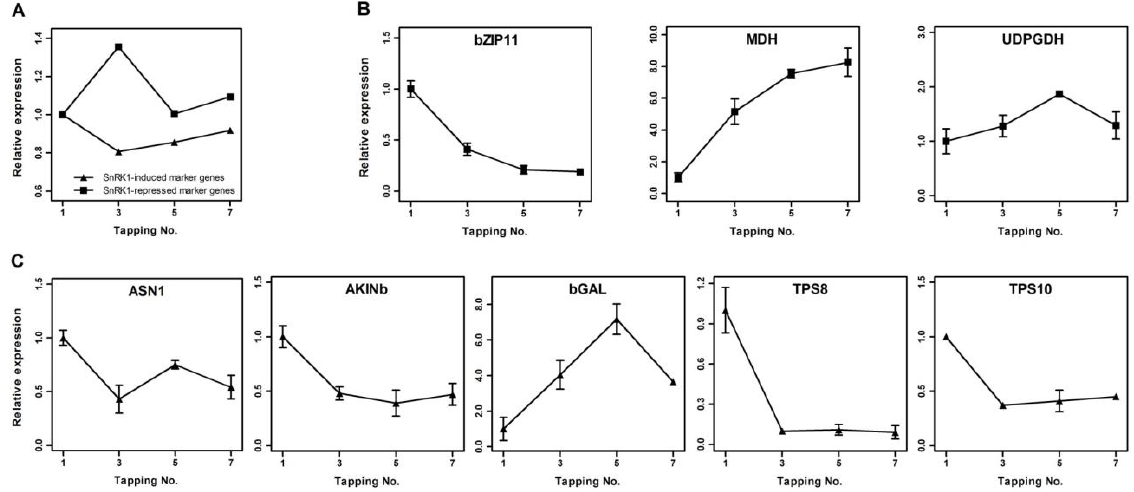
Figure 6. Changes in SnRK1 target gene transcript abundance in Hevea latex during tapping. ( A ) A total of 1032 putative SnRK1 target genes (511 induced and 521 repressed) reported in Arabidopsis (Baena-Gonzalez et al., 2007) were used as queries to identify their corresponding homologs in Hevea using the BLAST program. The expression of each target gene in latex during the tapping was scored in RPKM based on RNA sequencing data generated from the Illumina platform and normalized against the first tapping. Two hundred each of the most abundantly expressed SnRK1-induced and SnRK1-repressed target genes are presented. ( B ) Expression of three putatively down-regulated SnRK1 targets, bZIP11 , MDH and UDPGDH , analyzed by qPCR during tapping. ( C ) Expression of five putatively up-regulated SnRK1 targets, ASN1 , AKINb , bGAL , TPS8 and TPS10 , analyzed by qPCR during tapping. The qPCR data are means ± standard deviations of three independent biological samples, normalized against the first tapping.